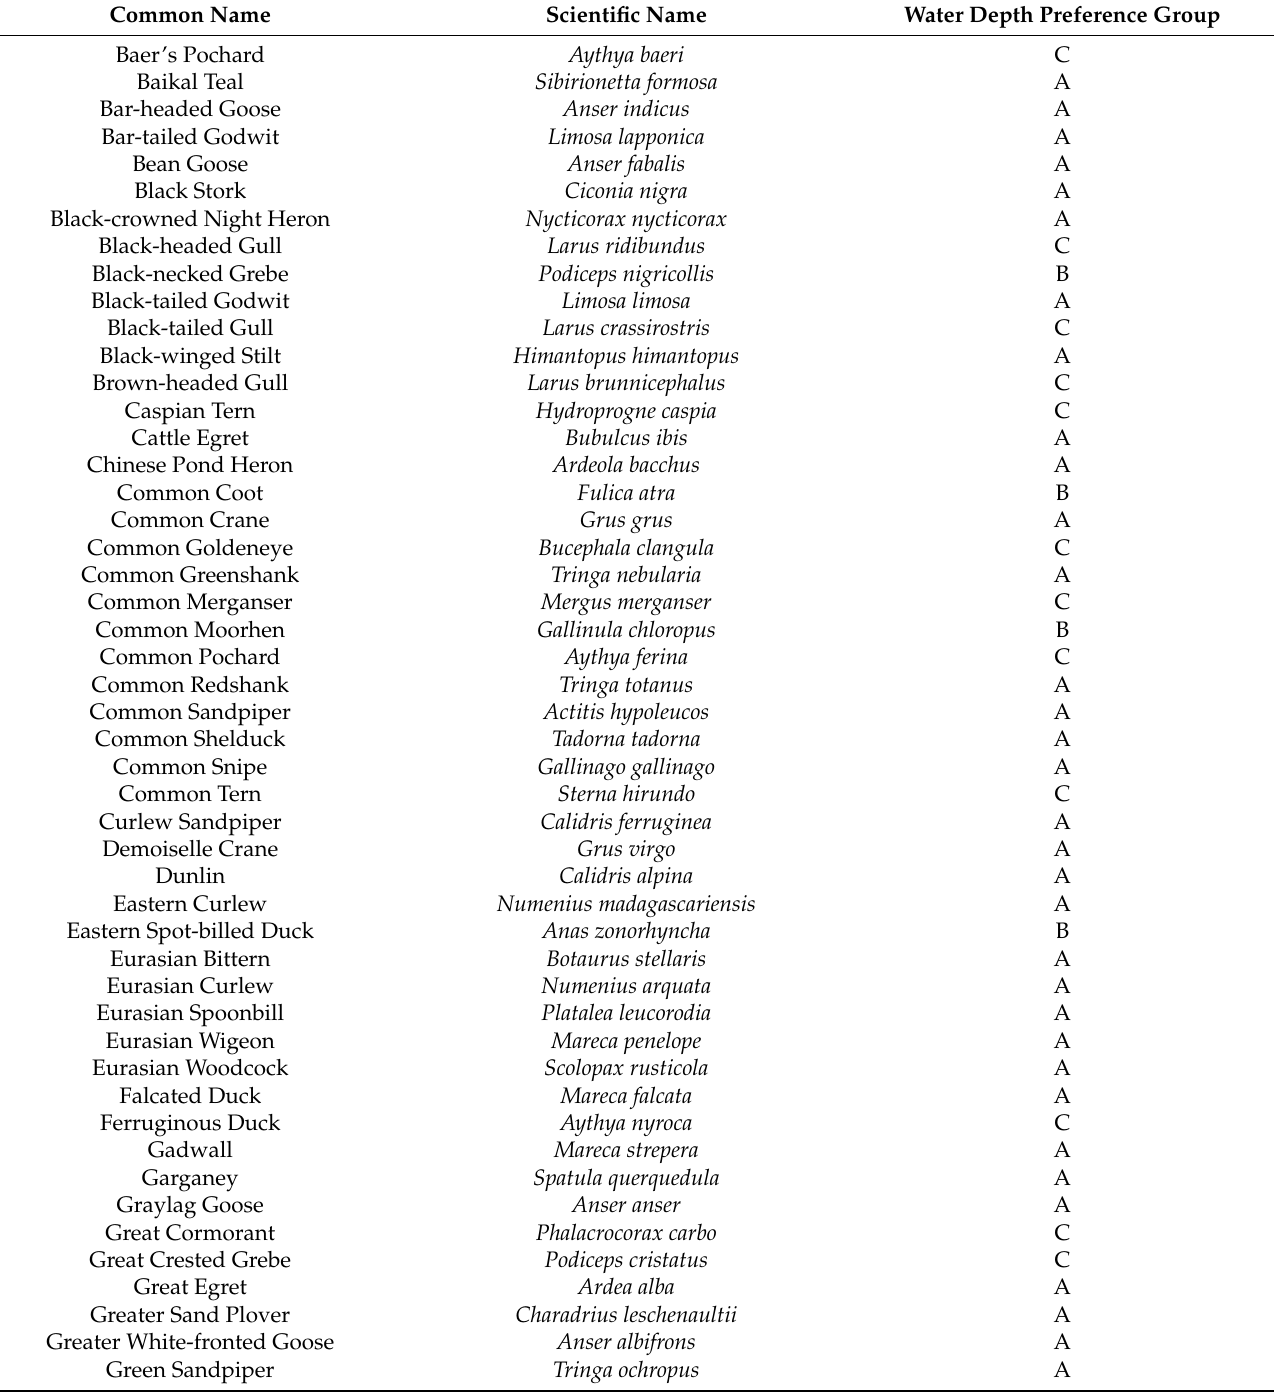
Table A1. Species recorded in all surveys and water depth preferences during the four pairs of selected dates. A, B, C sequentially represents the shallow-water preferring group, the moderate- depth-water preferring group, and the deep-water preferring